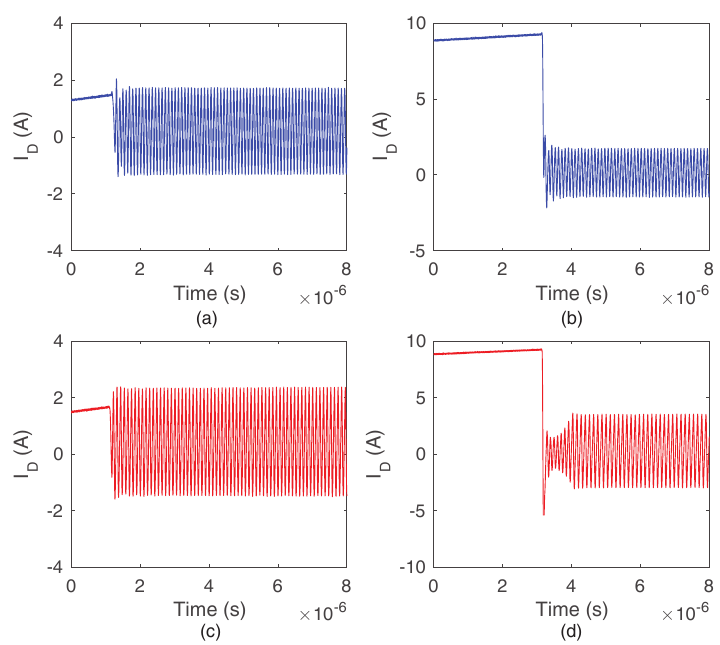
Figure 8. The oscillation waveforms of I D for type I (blue) and type II (red) self-sustained oscillation. ( a ) I L = 1.5 A. ( b ) I L = 10 A. ( c ) I L = 1.5 A. ( d ) I L = 10